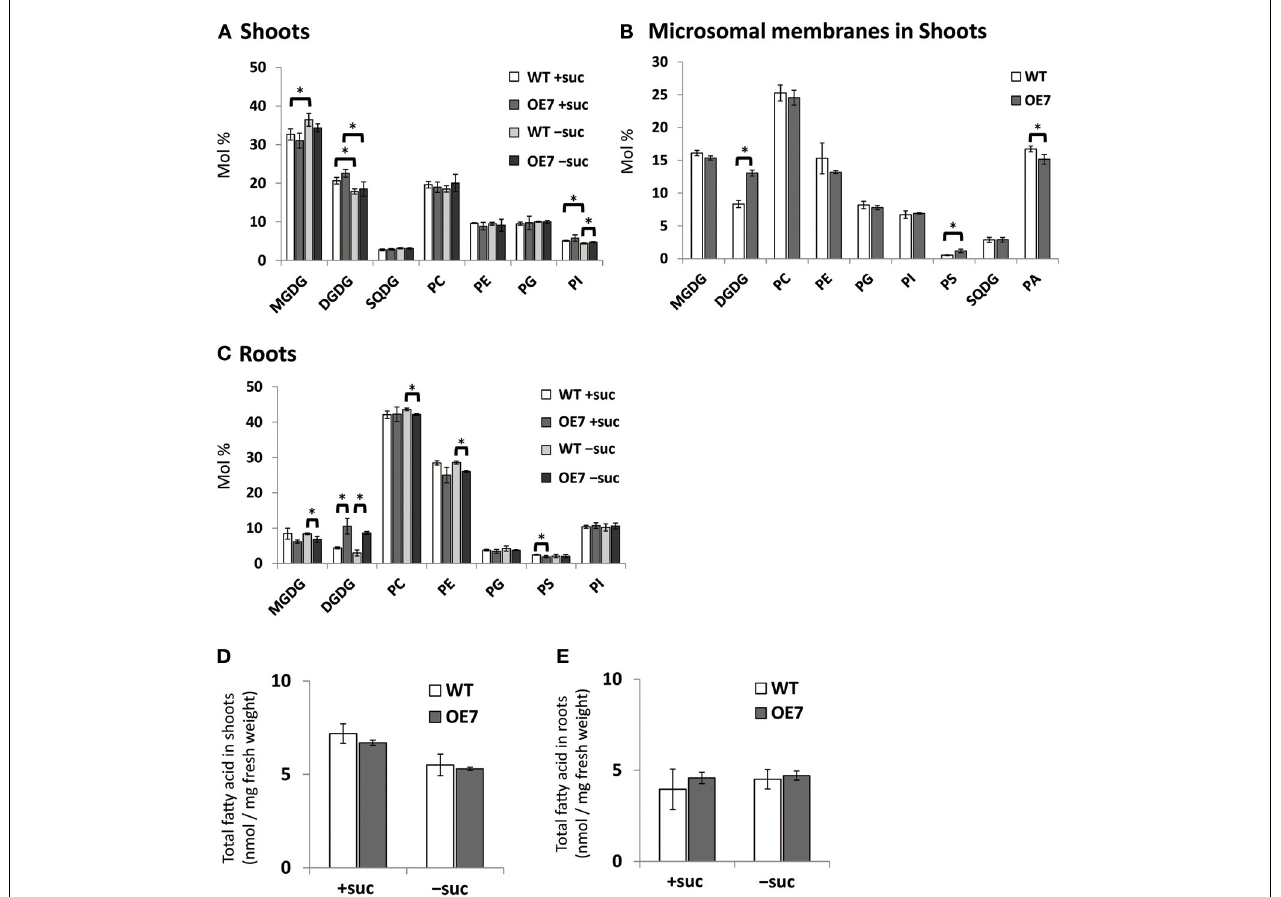
FIGURE 5 | Lipid analysis of WT and OE7 seedlings grown with or without exogenous sucrose. Molar ratio of membrane lipids of shoots (A) and roots (C) , and of microsomal lipids of shoots (B) , and total fatty acid content in shoots (D) and roots (E) . Plants were grown on MS medium supplemented with + suc or − suc for 10d (A,C) or 7d (B,D,E) were then transferred to ½MS agar with or without sucrose, respectively, and grown for